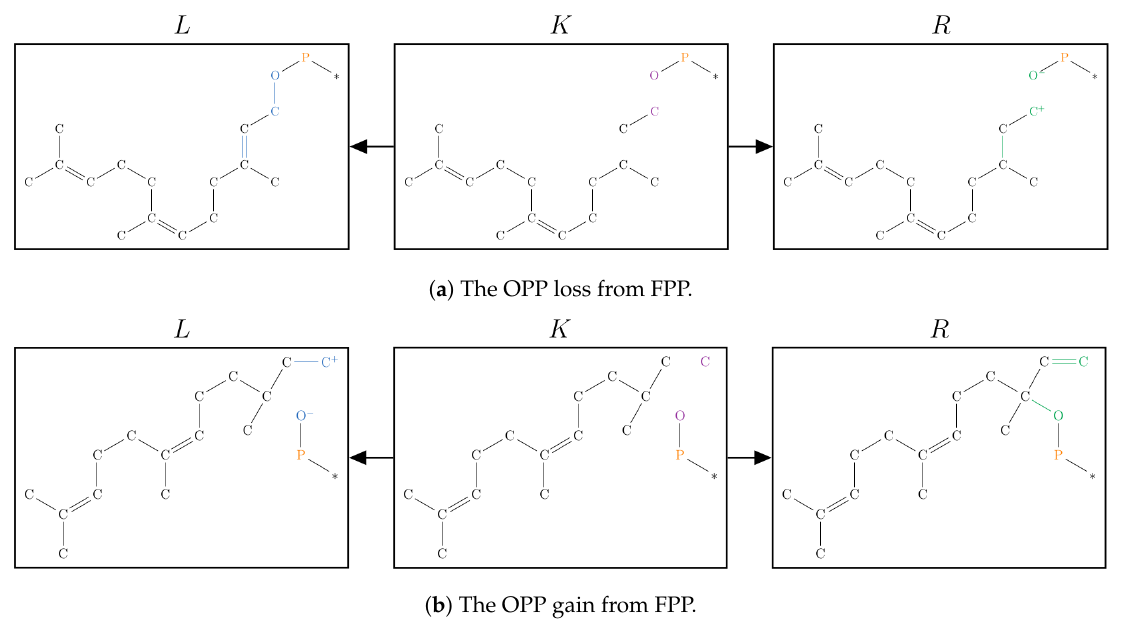
Figure 7. The graphical representation of the set of graph grammar rules used in Simulation